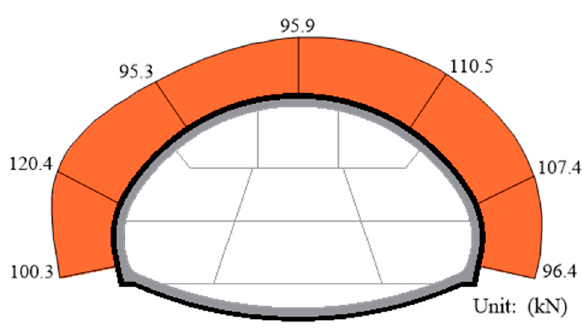
Figure 22. Final distribution of the axial forces at the end of the anchor bolts.